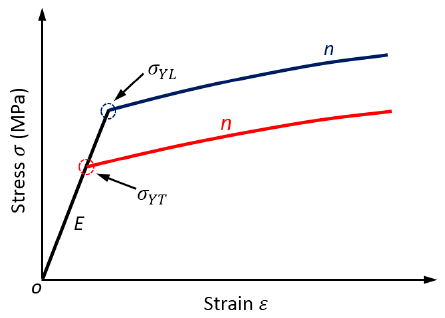
Figure 2. Stress strain curves of anisotropic materials.